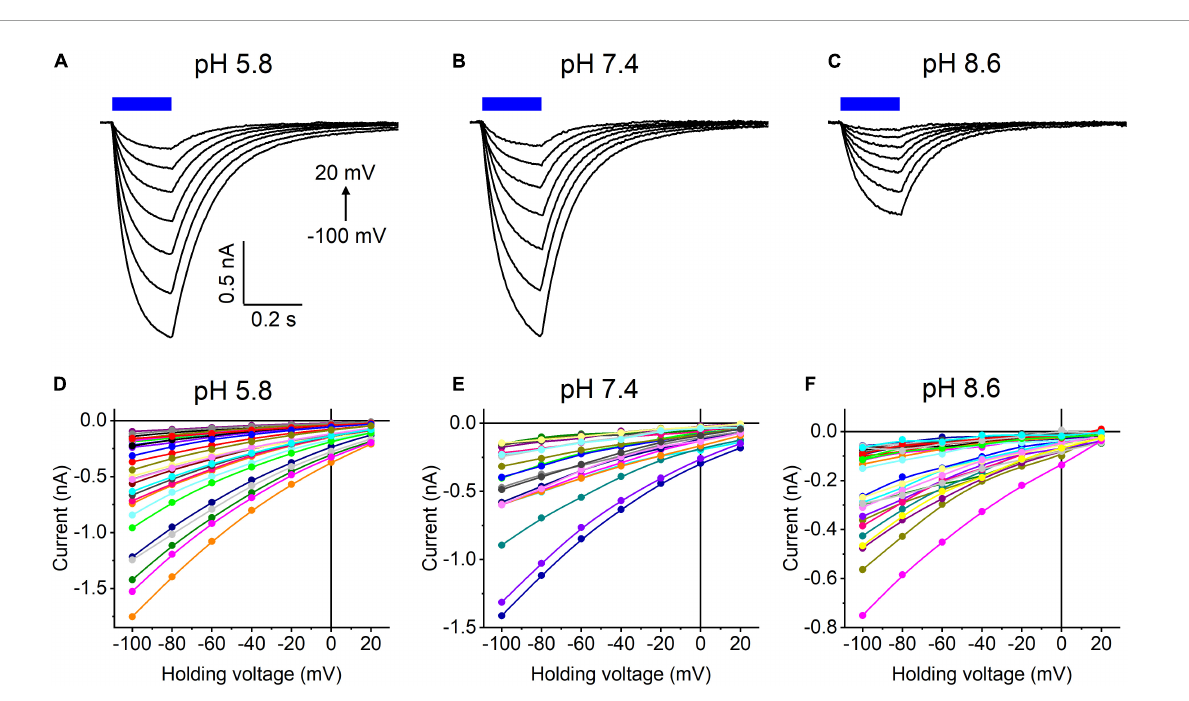
FIGURE4 (A–C) Photocurrent traces recorded from Hc CCR at the indicated external pH in response to a 200-ms light pulse (470 nm, 475 mA), the duration of which is shown as a colored bar on top. The holding voltage was varied from –100 to 20 mV in 20-mV steps. (D–F) Current-voltage relationships of Hc CCR measured in individual cells. The current amplitude was measured at the end of a 200-ms light